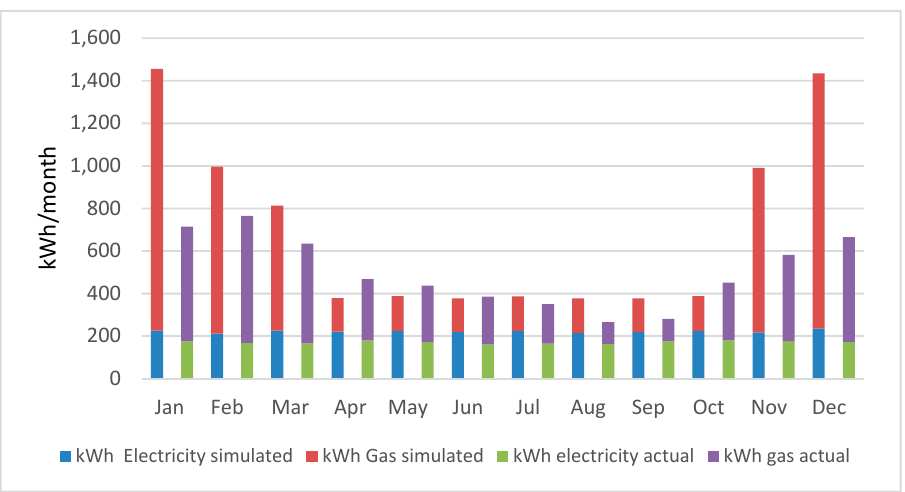
Figure 5. Monthly average for simulated and actual final energy consumption (kWh/month) per dwelling in building A.